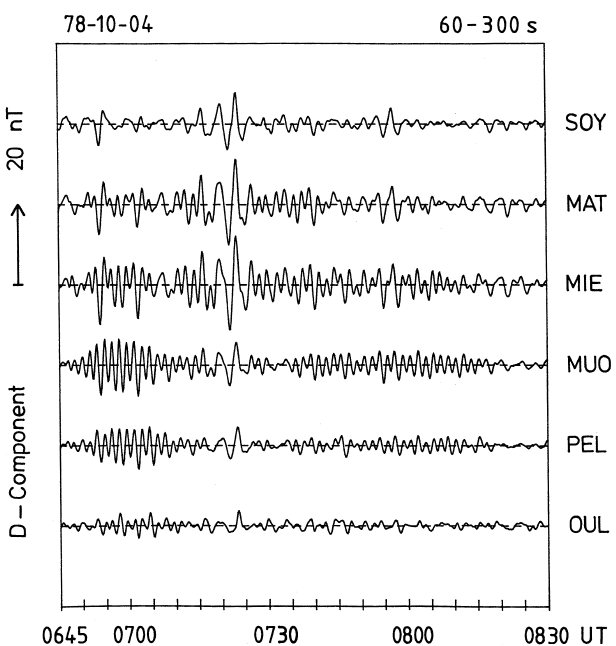
Fig. 2. Magnetic field variations recorded along profile 4 of the Scandinavian magnetometer array for the time interval October 4, 1978, 0645-0830 UT (0845-1030 MLT). The data have been band-pass filtered in the period range 60–300 s